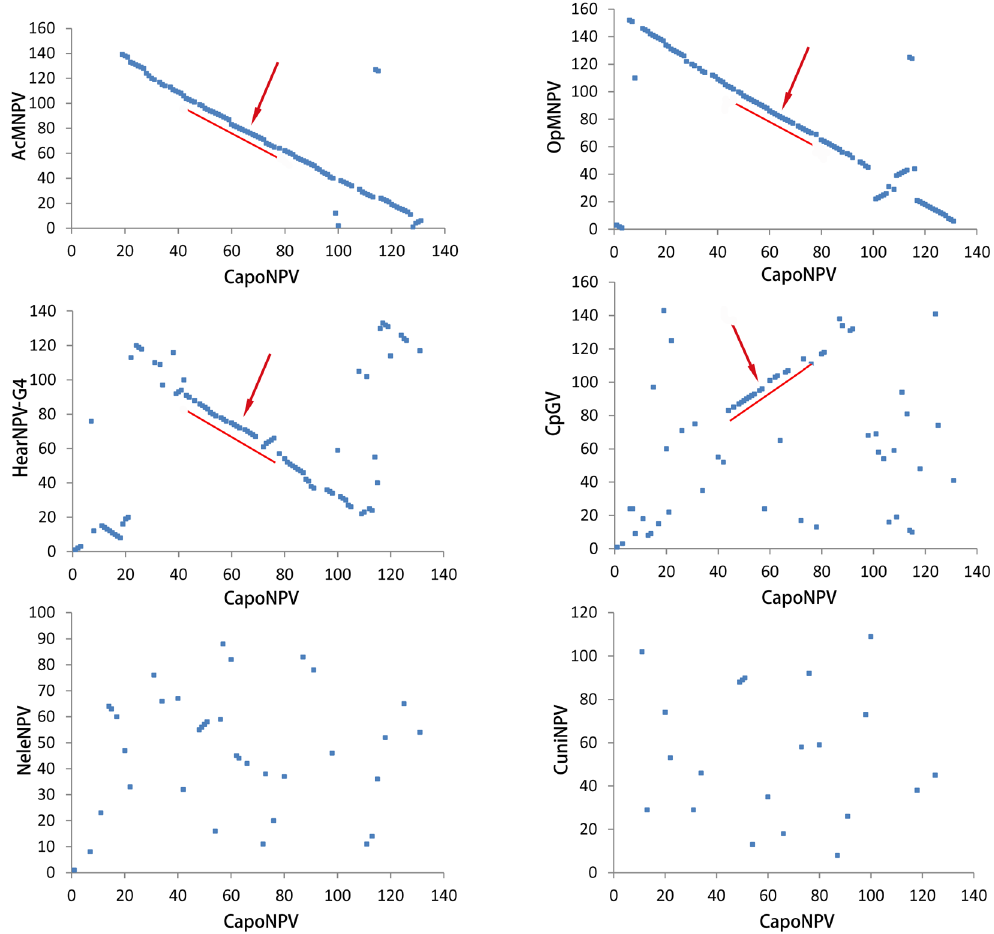
Fig 3. Gene parity plot analysis. Gene parity plots of CapoNPV against representative baculoviruses: AcMNPV (Group I clade “ a ” ), OpMNPV (Group I clade “ b ” ); HearNPV (Group II); CpGV (a betabaculovirus), NeleNPV (a gammabaculovirus) and CuniNPV (a deltabaculovirus). CapoNPV ORFs are on the X axis. The red line and arrow point to the collinearly conserved